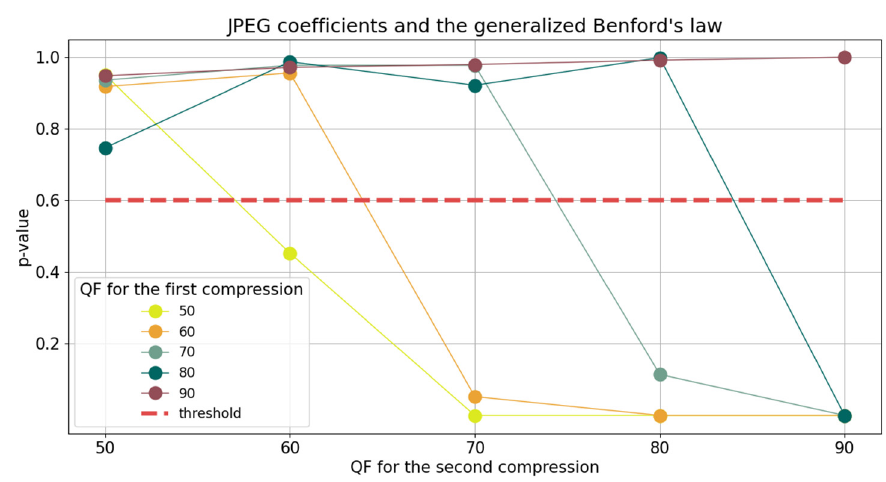
Figure 14. The JPEG coefficients compared to the GBL, using the Y channel.